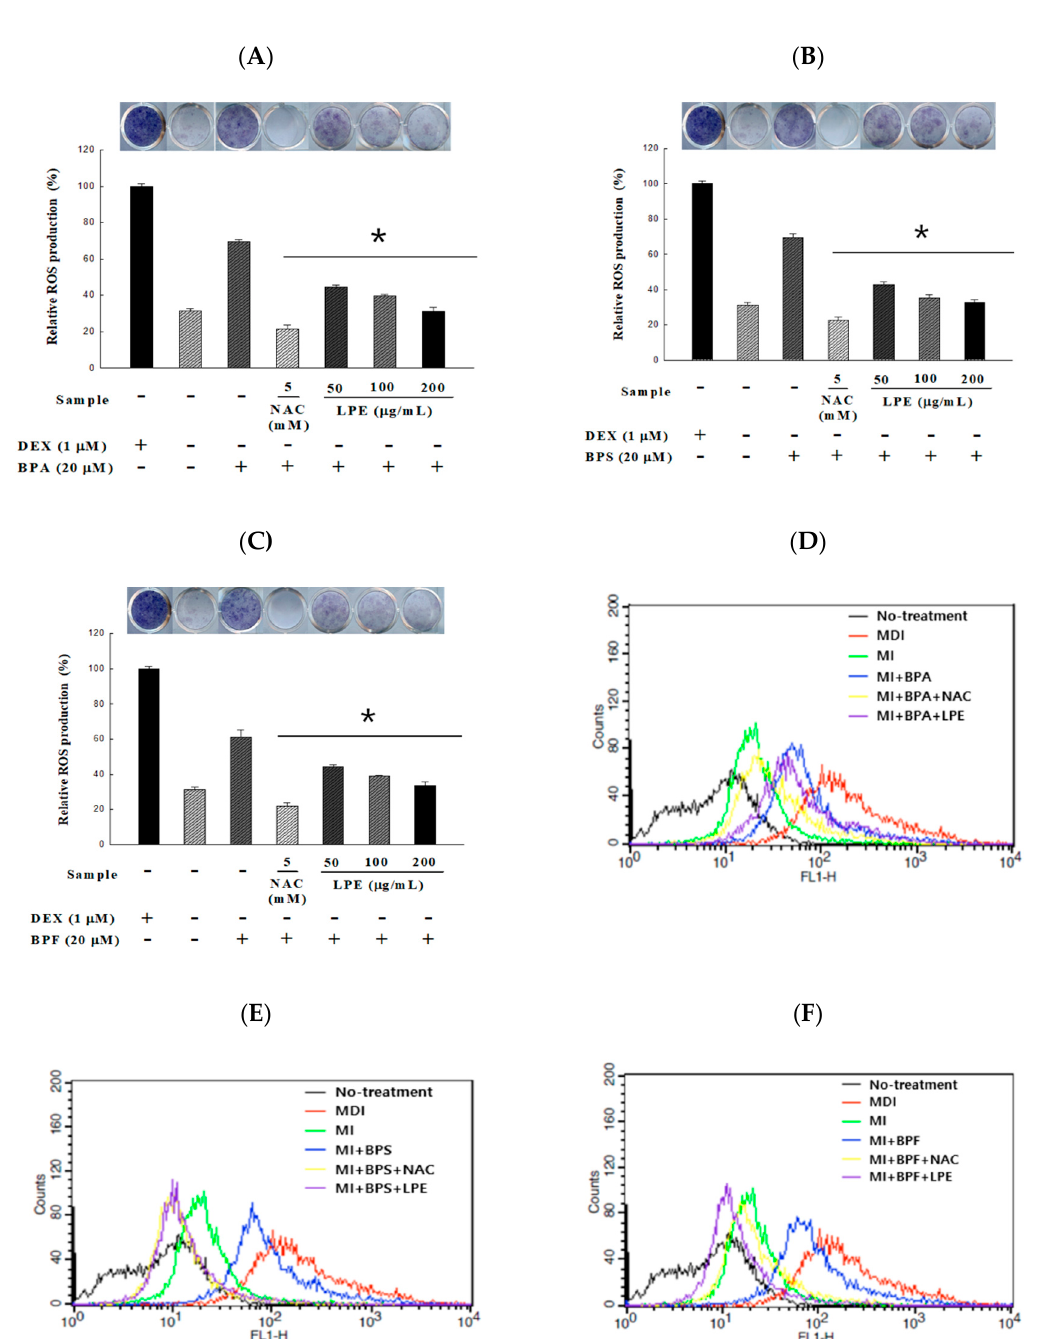
Figure 4. E ff ects of LPE on BPA-, BPS-, and BPF-induced 3T3-L1 adipocyte in reactive oxygen species (ROS) were determined. After 10 days of 20 µ M of bisphenol-induced adipocyte di ff erentiation, ROS was measured by ( A – C ) colorimetric analysis using NBT assay. Adipocyte were incubated with an NBT solution for 90 min, and the absorbance was measured at 593 nm. Another method of measuring ROS is ( D – F ) fluorescence analysis using DCFDA assay. Adipocytes were incubated with 10 µ M H 2 DCFDA for 30 min and the fluorescence was measured using flow cytometry. All values are presented as the mean ± SD. * p < 0.05 VS. MI treatment group, according to one-way analysis of